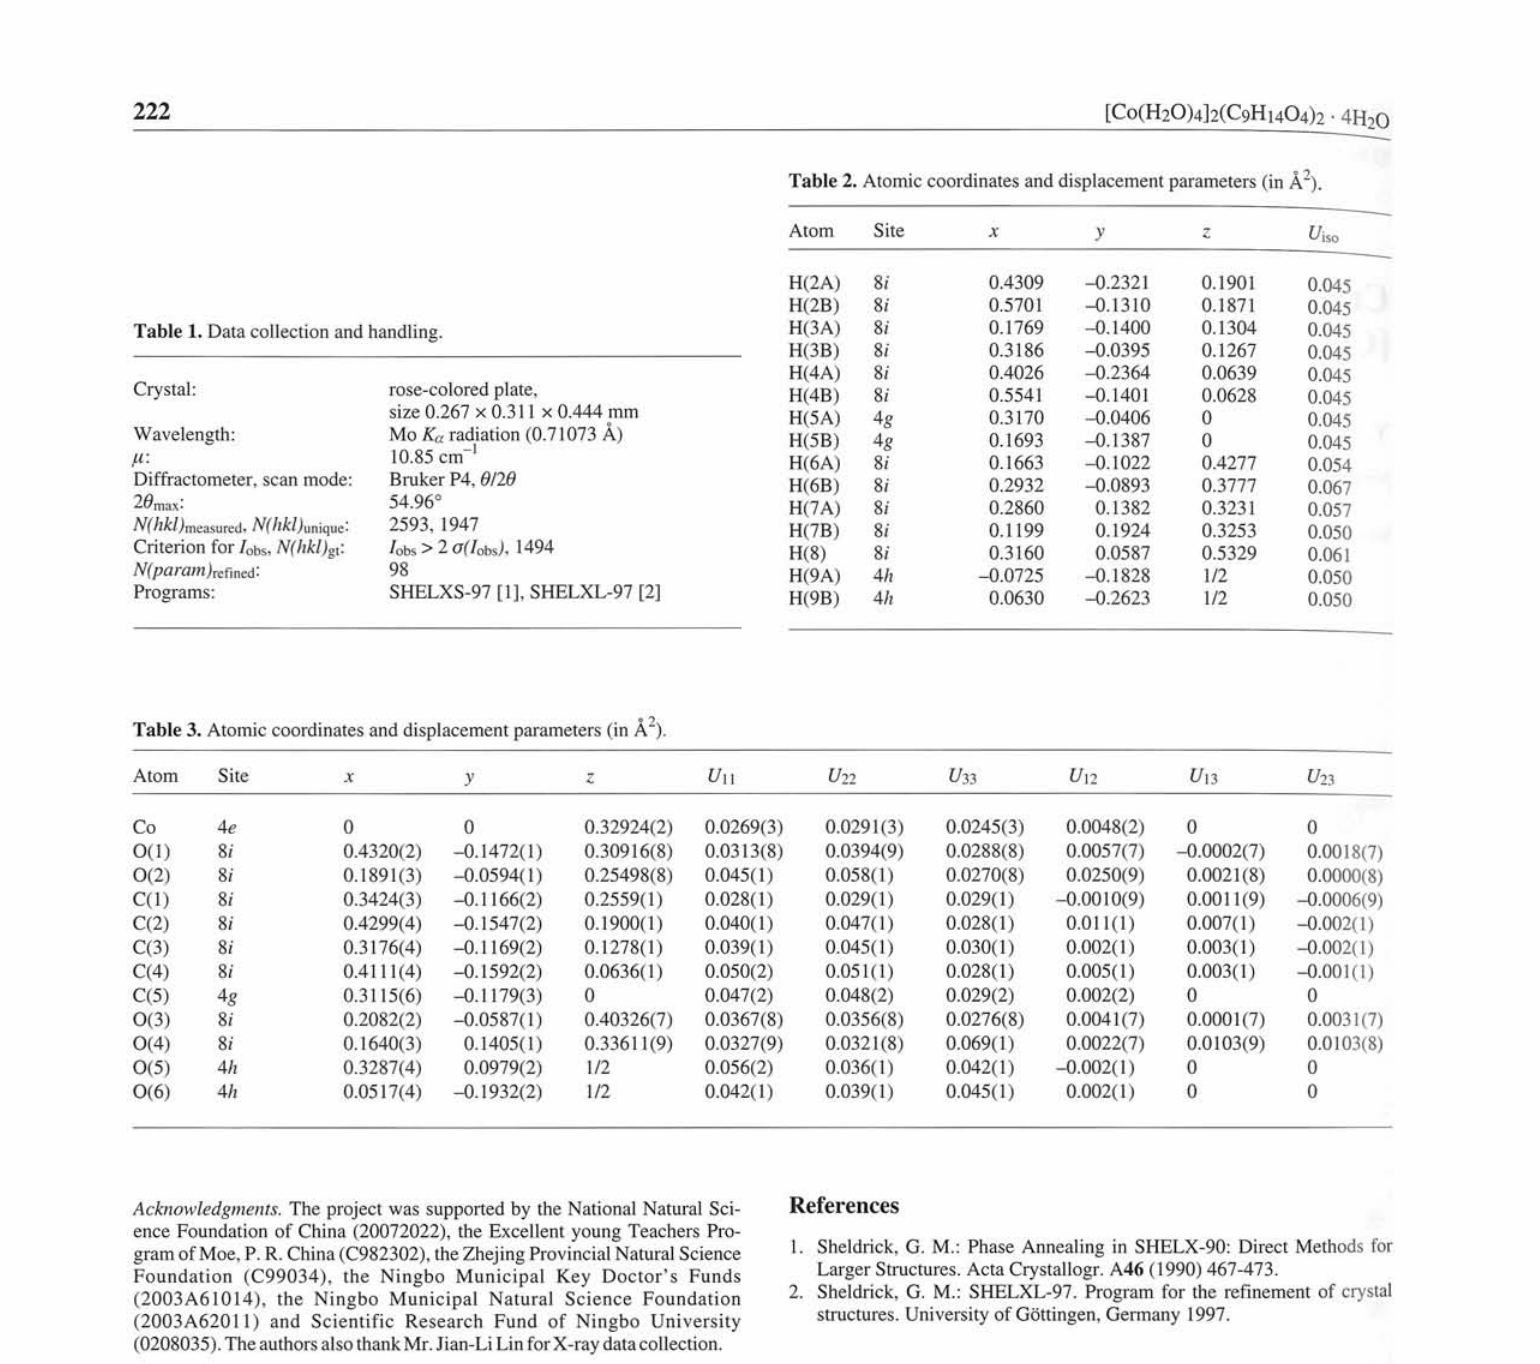
Table 2. Atomic coordinates and displacement parameters (in Â 2 ).